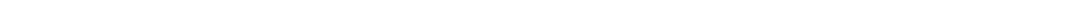
Fig. 8 Suppression of Tyro3 signal rescues decrease in spine abundance and tau mislocalization in mutant PGRN-KI mice. a Experimental protocol for knockdown vectors. AAV-Syn-EGFP was injected into the area adjacent to M2 at 6 weeks of age. Lentivirus for expression of Tau-shRNA, scrambled shRNA, B-Raf-shRNA, or Tyro3-siRNA, or plasmid vectors for expression of PKC α -shRNA, scrambled shRNA, or Gas6-shRNA dissolved in in vivo-jetPEI, were continuously injected into the subarachnoid space of the right M2 via osmotic pump from 8 to 12 weeks of age. Dendritic spines in layer 1 of M2 were observed by two-photon microscopy with three mice at 12 weeks of age. 8 to 10 images were obtained from one mice and the average of spine parameters were used for quantitative analyses ( N = 3). The protocols for vemurafenib and Gö6976 were similar to those shown in Fig. 6 7, and two-photon microscopy was performed at 12 weeks of age. b Static spine morphology was observed by two-photon microscopy. Spine protrusion number, length, head diameter, and volume were analyzed. * p < 0.05; ** p < 0.01 ( N = 3, Student ’ s t -test). Averages and s.e.m. are shown. c Images were obtained by two-photon microscopy at 0, 8, and 24 h on the last day of injection. Dynamic changes in spines were analyzed by serial observation. Spine formation and elimination were counted. * p < 0.05; ** p < 0.01 ( N = 3, Student ’ s t -test). Averages and s.e.m. are shown. d Lentivirus for expression of shRNA-Tau was injected according to the protocol. ** p < 0.01 ( N = 3, Tukey ’ s HSD test). Scrambled RNA was used as a control. Averages and s.e.m. are shown. e Lentivirus for expression of shRNA-B-Raf was injected according to the protocol. ** p < 0.01 ( N = 3, Tukey ’ s HSD test). Scrambled RNA was used as a control. Averages and s.e.m. are shown. f Plasmid for expression of shRNA-PKC α was injected according to the protocol. * p < 0.05; ** p < 0.01 ( N = 3, Tukey ’ s HSD test). Scrambled RNA was used as a control. Averages and s.e.m. are shown. g Lentivirus for expression of siRNA-Tyro3 was injected according to the protocol. Scrambled RNA was used as a control. ** p < 0.01 ( N = 3, Tukey ’ s HSD test). Scrambled RNA was used as a control. Averages and s.e.m. are shown. h Plasmid for expression of shRNA-Gas6 was injected according to the protocol. Scrambled RNA was used as a control. ** p < 0.01 ( N = 3, Tukey ’ s HSD test). Scrambled RNA was used as a control. Averages and s.e.m. are shown. i Mice received oral administration of vemurafenib (32 mg/kg of BW/day) from 6 to 12 weeks of age, and two-photon microscopic analysis was performed at 12 weeks. ** p < 0.01 ( N = 3, Tukey ’ s HSD test). Averages and s.e.m. are shown. j Gö6976 (4.4 μ M) or PBS was injected via osmotic pump into the subarachnoid space of PGRN-KI and C57BL/6J mice from 10 to 12 weeks of age, and two-photon microscopic analysis was performed at 12 weeks. ** p < 0.01 ( N = 3, Tukey ’ s HSD test). Averages and s.e.m. are